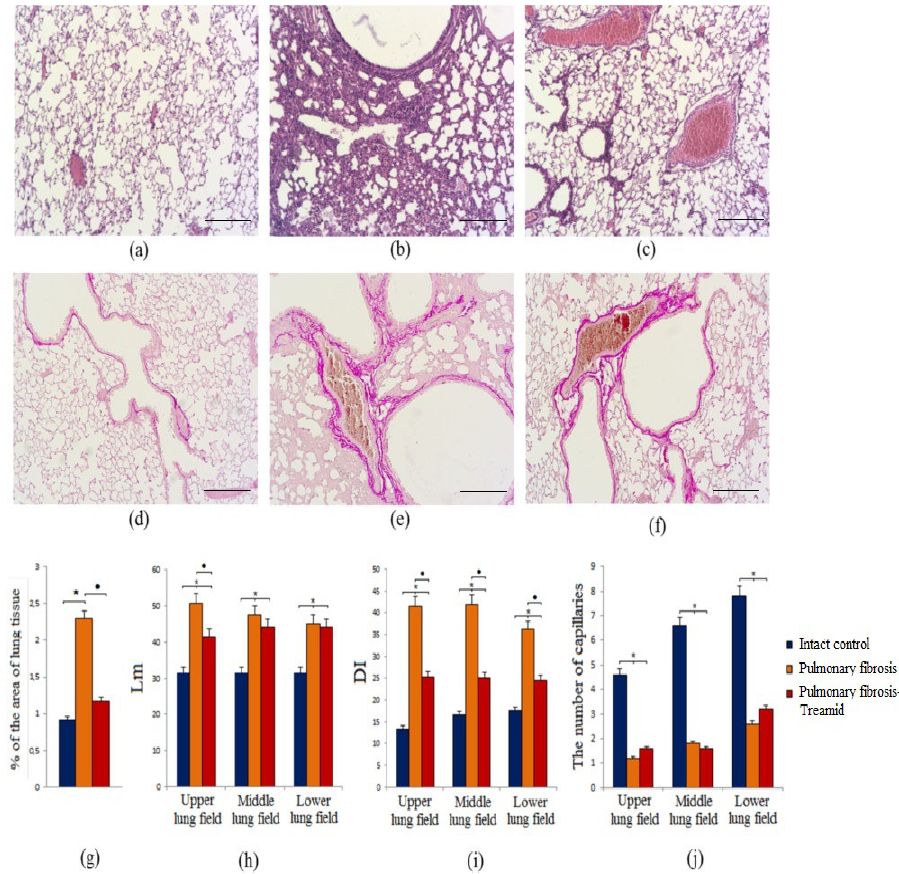
Figure 1. Photomicrographs of left lung sections (middle pulmonary field) obtained from male C57BL/6 mice on 21 st day after the BLM injection (d21). ( a , d ) M ice of Intact control; ( b , e ) mice with pulmonary fibrosis; ( c , f ) mice with pulmonary fibrosis treated Treamid. ( a – c ) Tissues stained with hematoxylin-eosin; ( d – f ) tissues stained by Van Gieson, scale bar 100 μ m. ( g ) Content of the connective tissue in the lungs of C57BL/6 mice at the pulmonary fibrosis on d21. ( h ) The mean linear intercept (Lm) in the lungs of male C57BL/6 mice with pulmonary fibrosis on d21 (upper, middle and lower pulmonary field). ( i ) Destructive index (DI) in the lungs of C57BL/6 mice with pulmonary fibrosis on d21 (upper, middle and lower pulmonary field). ( j ) The number of capillaries in five consecutive fields of lungs sections (upper, middle and lower pulmonary field) obtained from male C57BL/6 mice on d21. Groups: intact control; mice with pulmonary fibrosis (pulmonary fibrosis); mice with pulmonary fibrosis treated Treamid (pulmonary fibrosis+Treamid). * p < 0.05 significance of difference compared with intact control group, ● p < 0.05 significance of difference compared with the pulmonary fibrosis group.